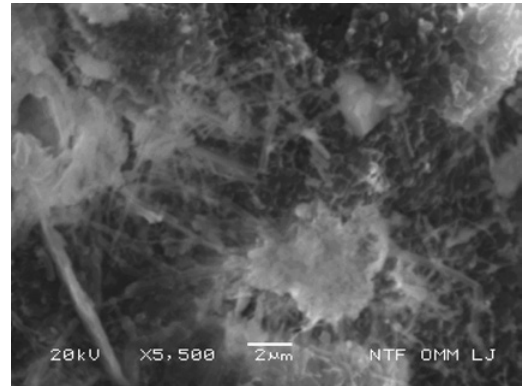
Figure 3 Micro fractography of the sample BI with ettringite crystals; SEM, SEI.